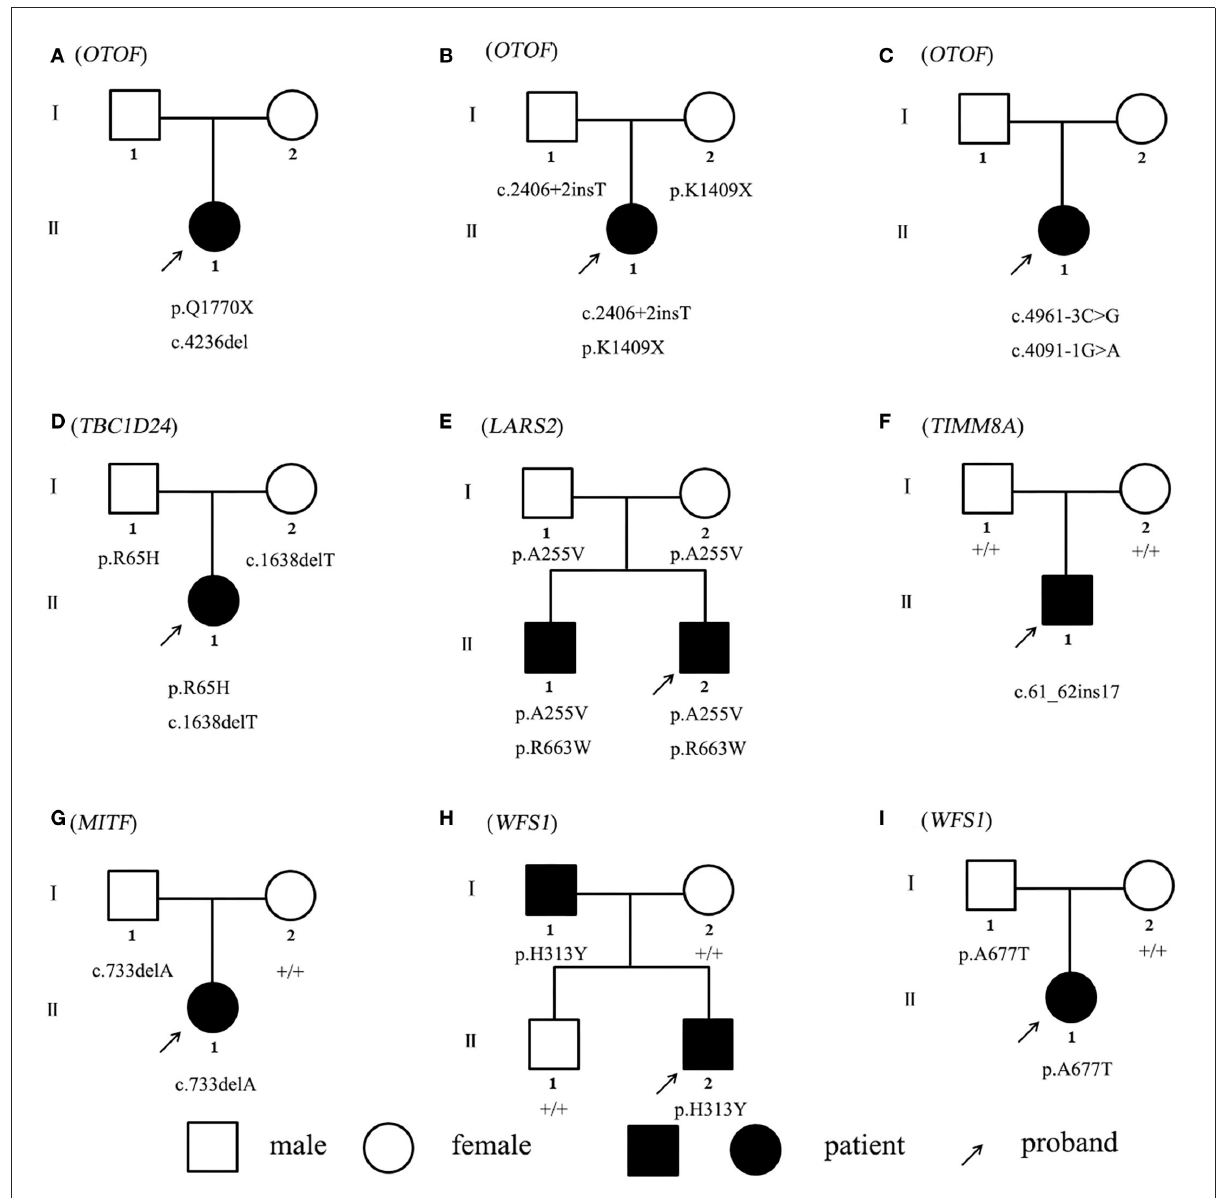
FIGURE1 (A–I) Pedigrees of nine families. + represents the wild type after Sanger sequencing.